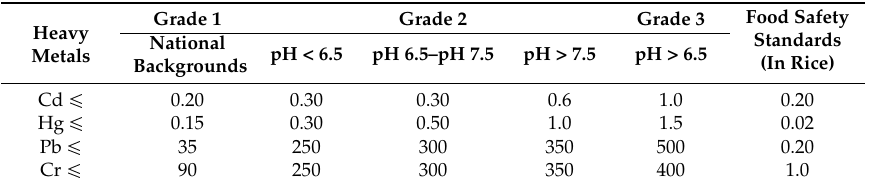
Table 1. Environmental quality standard for soils in China (GB 15618-1995) [22], heavy metal standards for food safety (GB2715–2005) [23] (mg (cid:4) kg